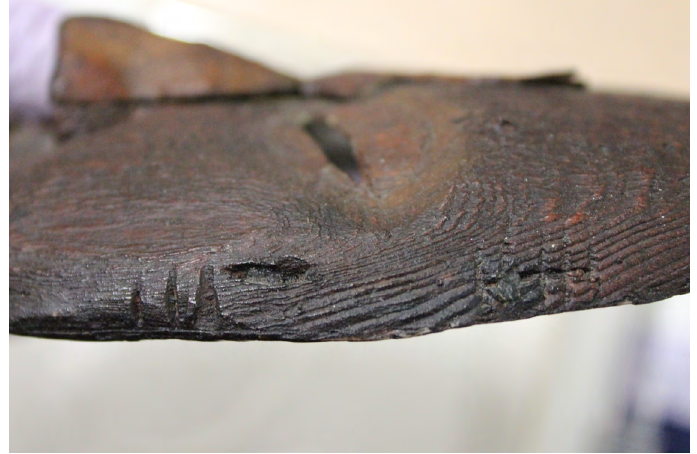
Figure 8. Incised marks on the left lateral edge of one of two complete masks (PfFm-01:1772-1777) found at Button Point. There are sets of five marks with a perpendicular line running through them, similar to the skeletal motifs seen on animals and the marks seen on the drums. Three incised lines mark the gouged hole that would have been fit with a leather thong to attach the mask to the wearer’s head. Photo by Christopher B. Wolff. Canadian Museum of